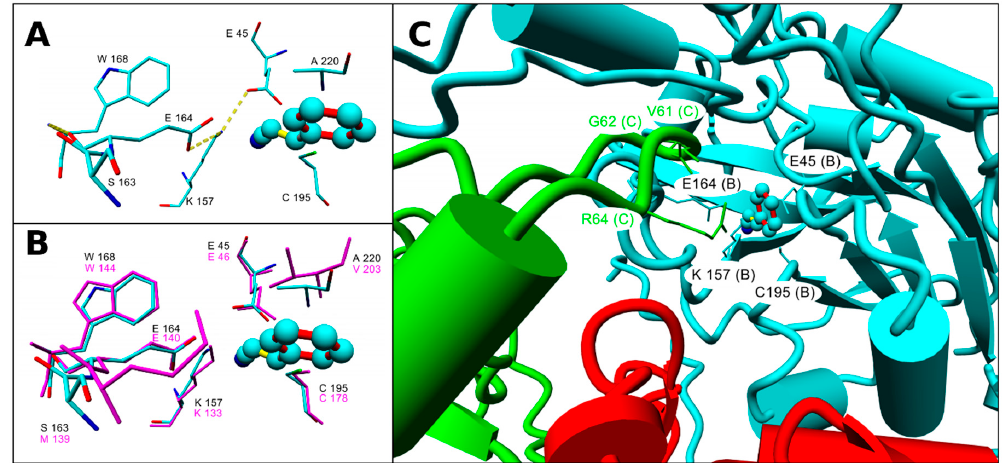
Figure 2. ( A ) Active site residues of NitAb with docked cinnamonitrile (CN): amino acid residues which are within 0.4 nm from ligand or could participate in controlling the nitrilase activity [22] are shown. These residues are also labelled in the multiple sequence alignment (Figure S3 in Supplementary Materials). Hydrogen bonds formed by catalytic residues are shown with yellow dotted lines. ( B ) Overlay of the active site residues of NitAb (element color, black labels) and NitTv1 (magenta color, magenta labels). ( C ) Orientation of monomers in tetrameric NitAb. Active site of monomer B with docked CN is framed by the residues from monomer C (green color) and monomer A (red color). Residues of monomers A, B and C within distance 0.3 nm from docked CN are shown with monomer name in brackets. The catalytic tetrad is shown in monomer B.